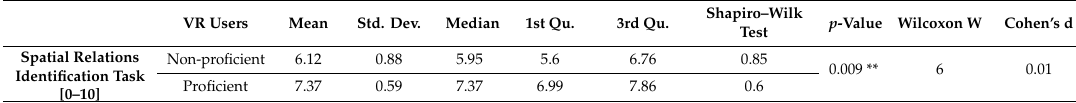
Table 2. Analysis of measured variables according to VR expertise.